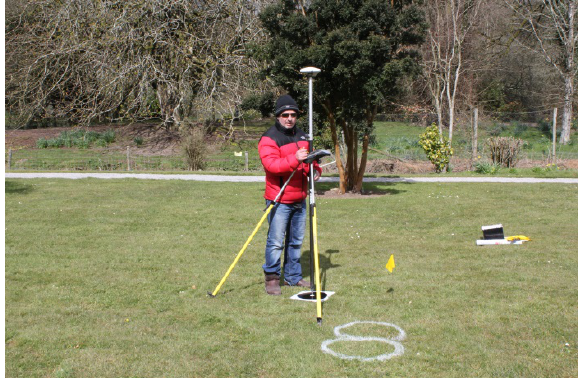
Figure 2: The stabilised Trimble GoeXR Network RTK GPS used to get the coordinates of the target centres.